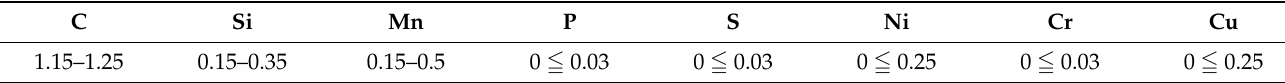
Table 3. Cutting parameters.